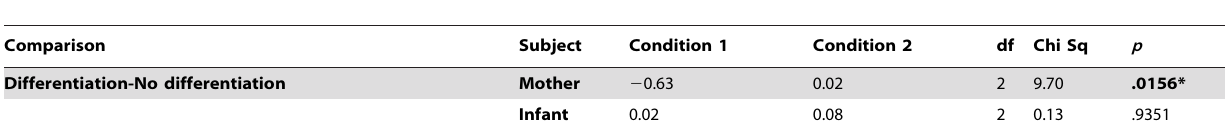
Table 4. Post hoc test for the effect of the differentiation capacity on the response differences for both the infant and the mother.